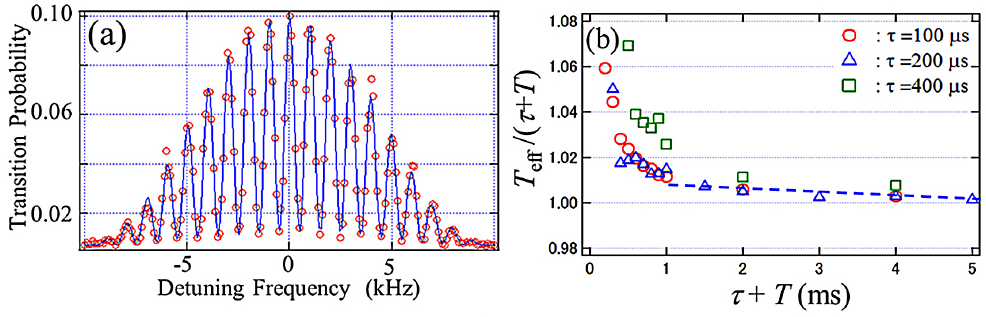
Figure 3. ( a ) Ramsey fringes. τ = 100 µ s, T = 900 µ s; ( b ) T eff versus τ + T for different τ .